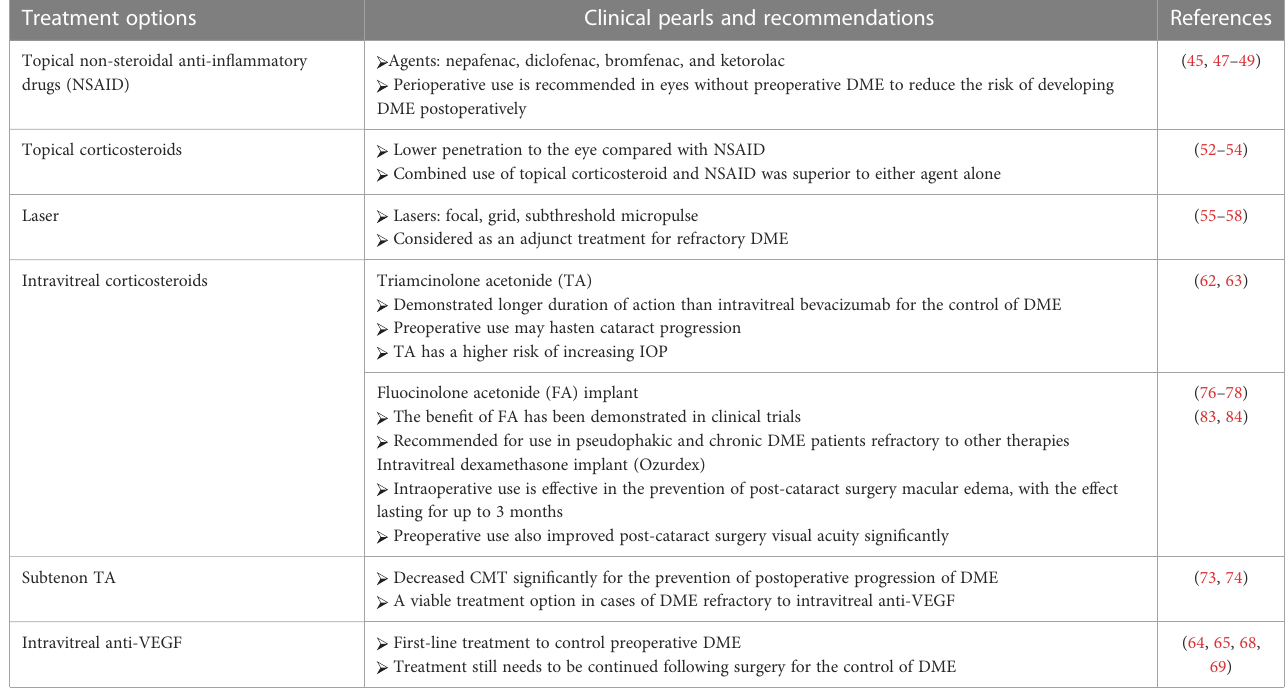
TABLE 1 Perioperative treatment options for DME in cataract